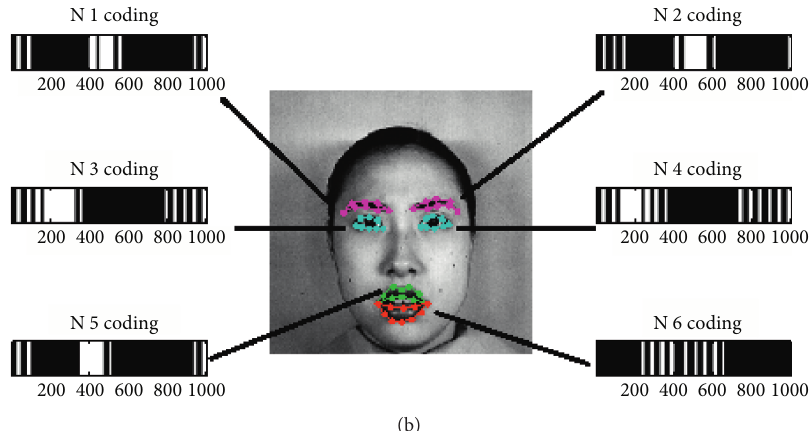
Figure 5: Image facial expression feature extraction and the coding in row direction results in JAFFE. (a) Happy expressions. (b) Angry